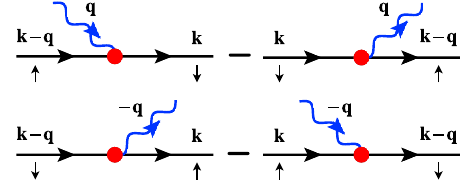
FIG. 14. Schematics of the collision integrals in Eq.